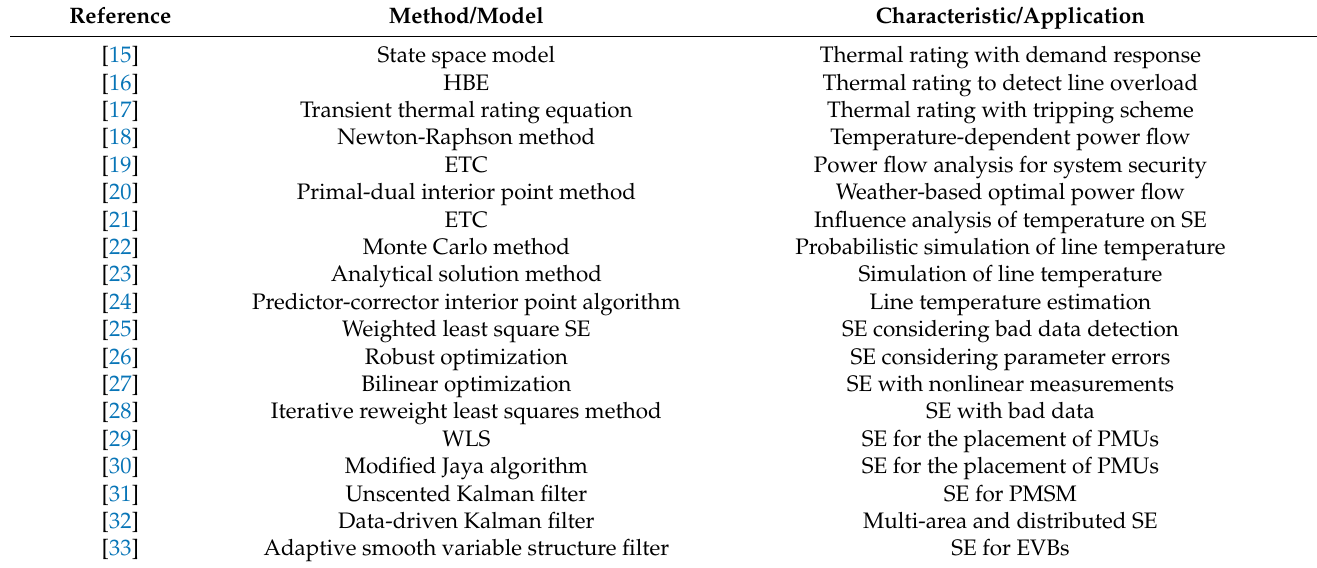
Table 1. Comparative literature survey on state-of-the-art SE methods.